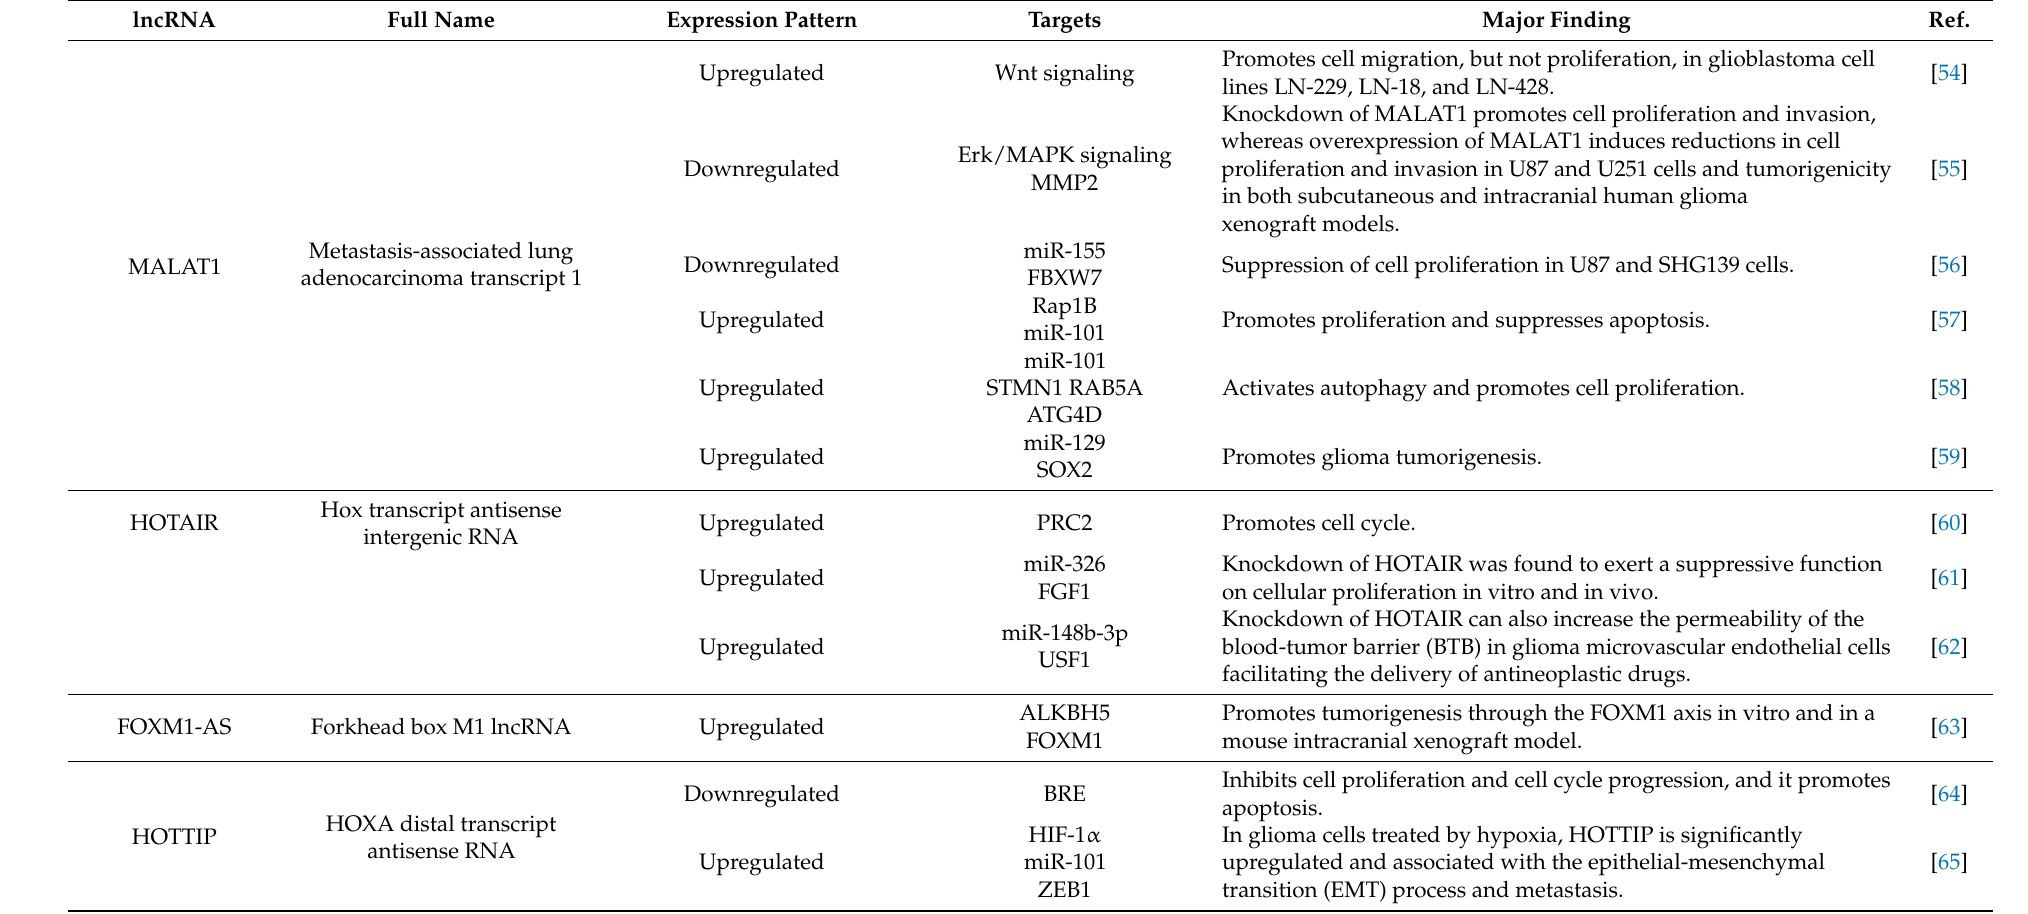
Table 1. LncRNA status in glioma and